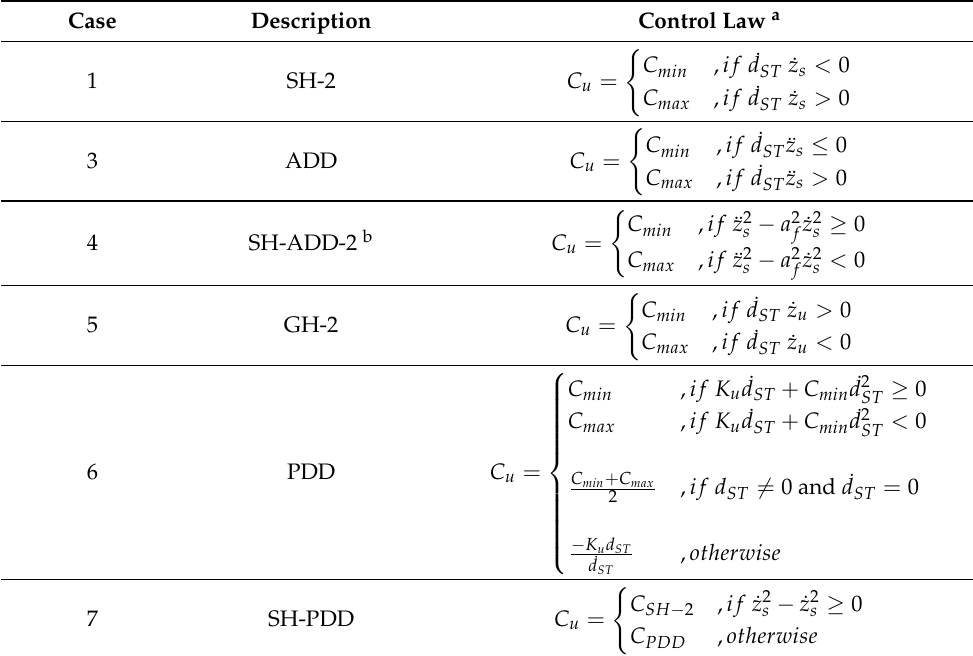
Table 2. Semi-active control algorithms applied in the vehicle suspension systems (Figure